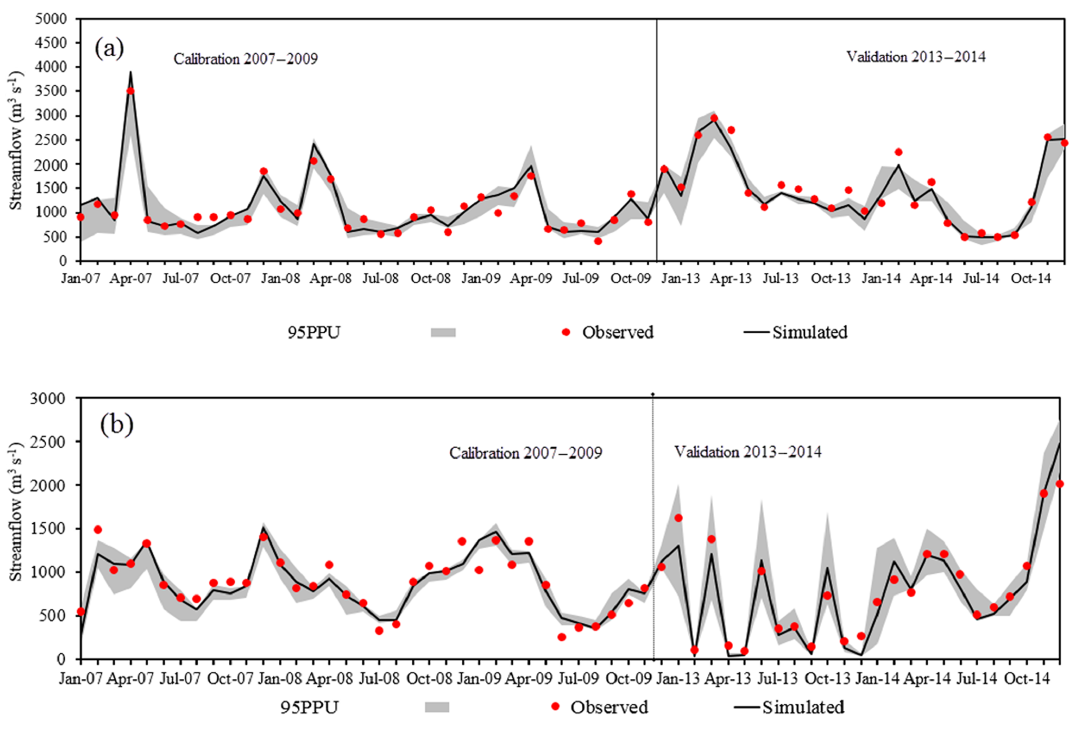
Figure 4. Observed vs. simulated streamflow and 95% uncertainty interval (95PPU; see Abbaspour, 2015) with P factors of 0.83 and 0.76 and R factors of 0.65 and 0.69 for the (a) BH and (b) MT watersheds, respectively.